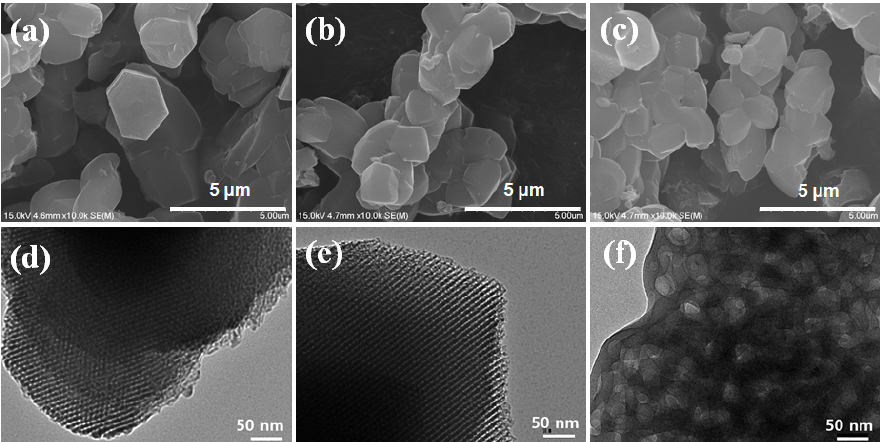
Figure 9. SEM ( a – c ) and TEM ( d – f ) images of ( a , d ) SBA15-Li-40-700, ( b , e ) SBA15-K-40-700 and ( c , f ) SBA15-Ca-40-700 after thermal treatment at 700 °C using different metal ions (Li + , K + and Ca 2+ ) with Si/metal ion = 40.